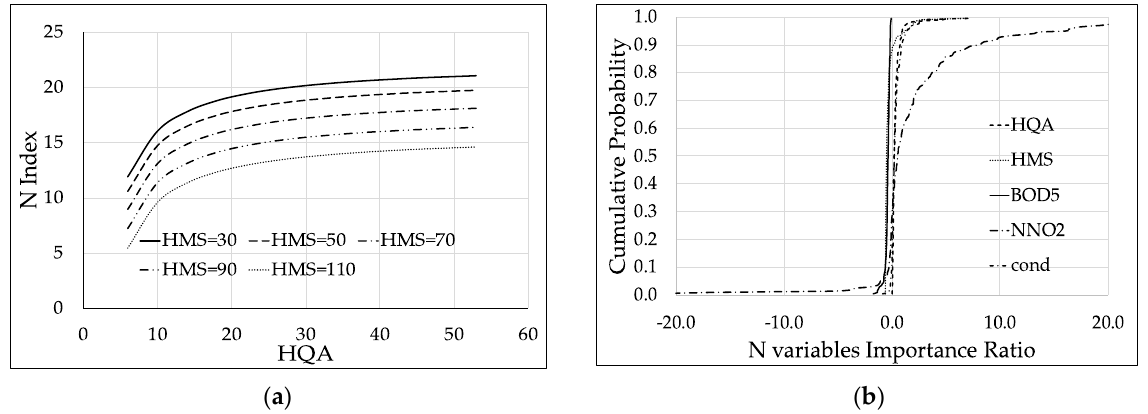
Figure 5. ( a ) HMS-HQA nonlinear relationship with N; ( b ) importance ratio of independent variables with N.